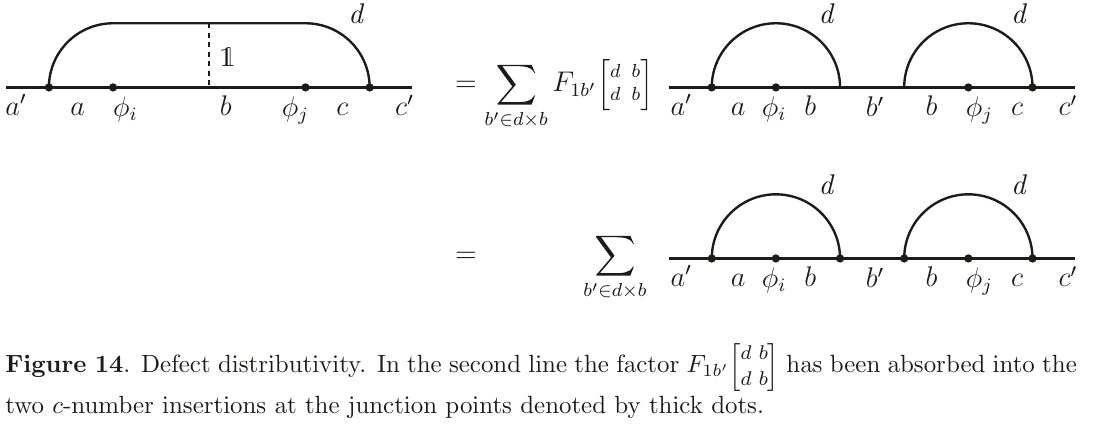
d b has been absorbed into the d b (cid:20) (cid:21)